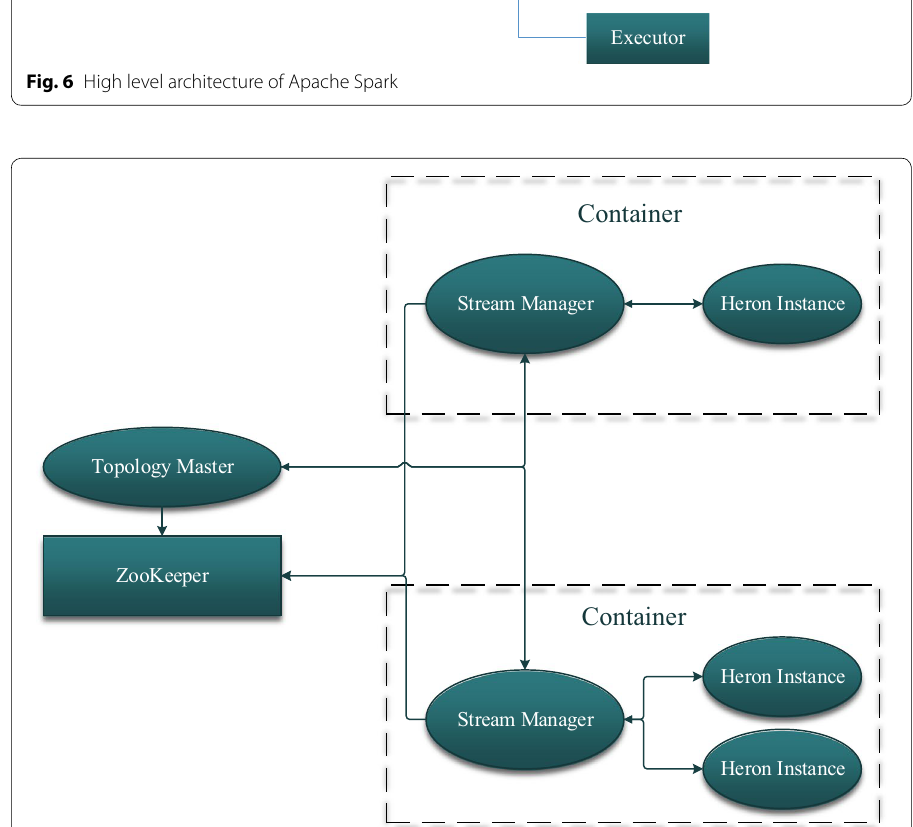
Fig. 7 High level architecture of Apache